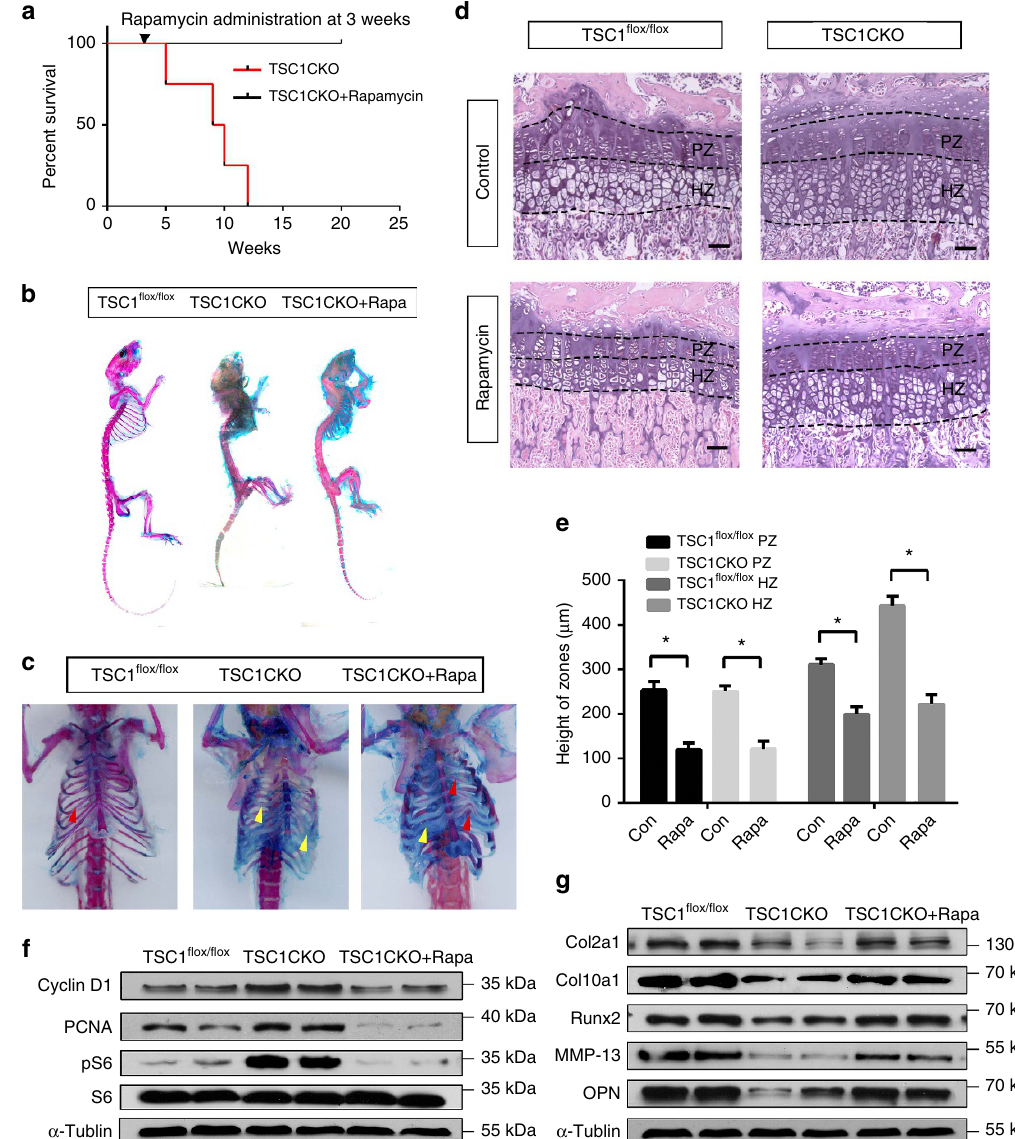
Figure 6 | Rapamycin restores normal endochondral bone development. ( a ) Kaplan–Meier Survival curve of TSC1CKO mouse and TSC1CKO mouse treated with rapamycin (2mgkg (cid:2) 1 per day) for 4 weeks at 3 weeks after birth. ( b , c ) Alcian blue and Alizarin red staining of skeletons ( b ) and thorax ( c ) at 12 weeks in TSC1 flox/flox mouse, TSC1CKO mouse and TSC1CKO mouse administered rapamycin (2mgkg (cid:2) 1 per day). Red triangle shows the ossificated part of the rib, yellow triangle shows the un-ossificated cartilage rib. ( d , e ) HE staining ( d ) and quantification analysis ( e ) of 4-week-old control and TSC1CKO mouse tibia treated with or without rapamycin (2mgkg (cid:2) 1 per day) from 2 weeks after birth. Scale bar, 100 m m. Student’s t -test, * P o 0.05, n Z 3; Error bars indicate s.d. ( f , g ) Western blot analysis showing the expression of PCNA, Cyclin D1, pS6 ( f ), and differentiation markers such as Col2a1, Col10a1, RUNX2, MMP-13 and OPN ( g ) in epiphyseal cartilage harvested from TSC1CKO mouse tibia at 4 weeks with or without 2 weeks of rapamycin